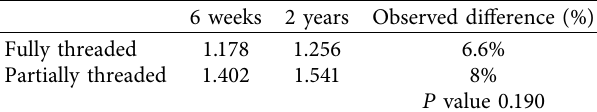
Table 3: Neck-to-screw